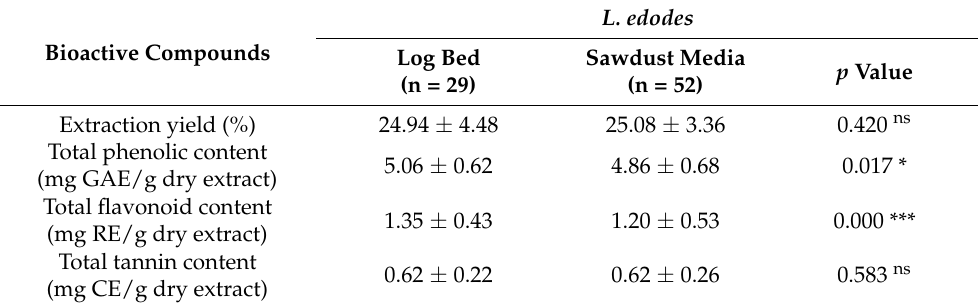
Table 3. Bioactive components of the methanolic extract in Lentinula edodes cultivated on log bed and sawdust media.